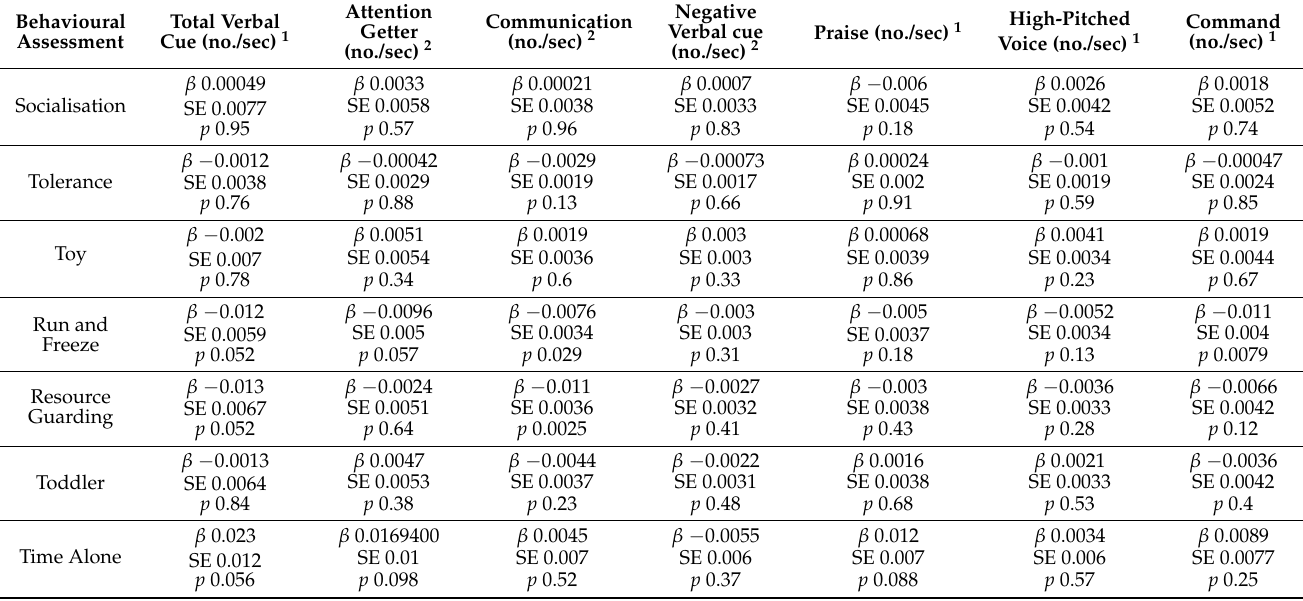
Table 7. Generalised linear mixed model of the effect of canine behavioural assessment on human verbal cue. Behavioural